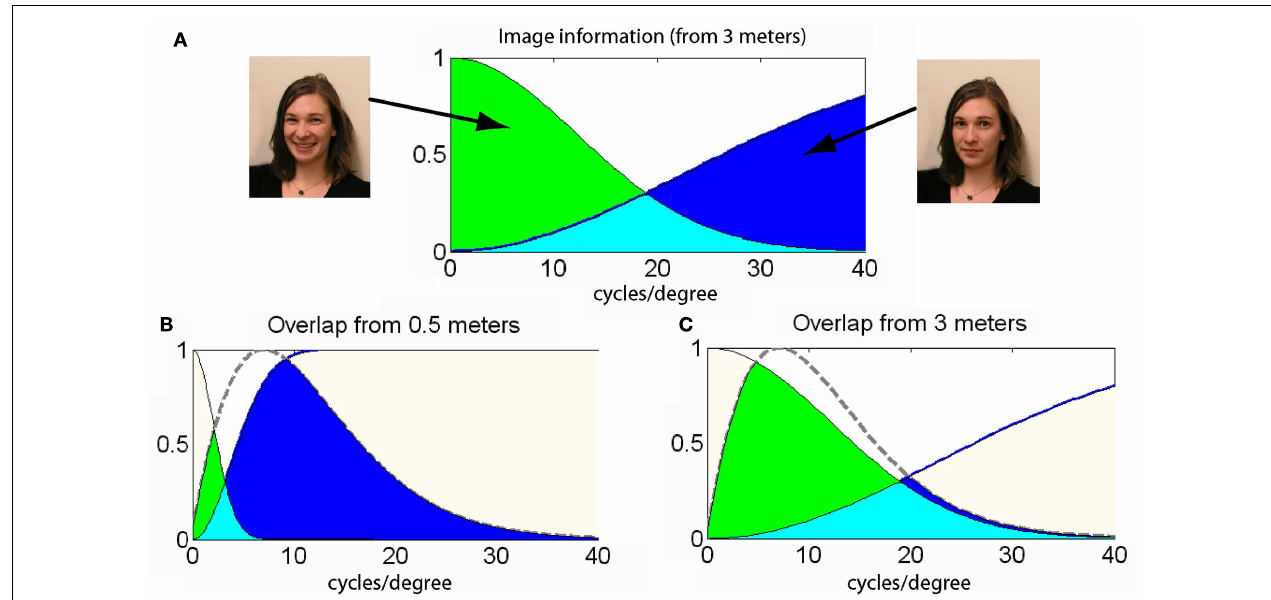
as the dashed-gray line) is predominantly driven by the low spatial frequency component: observers should preferentially perceive the happy face. (C) From a distance of 0.5m, the visible information is predominately from the high spatial frequency component: as a result, observers should see a neutral face.